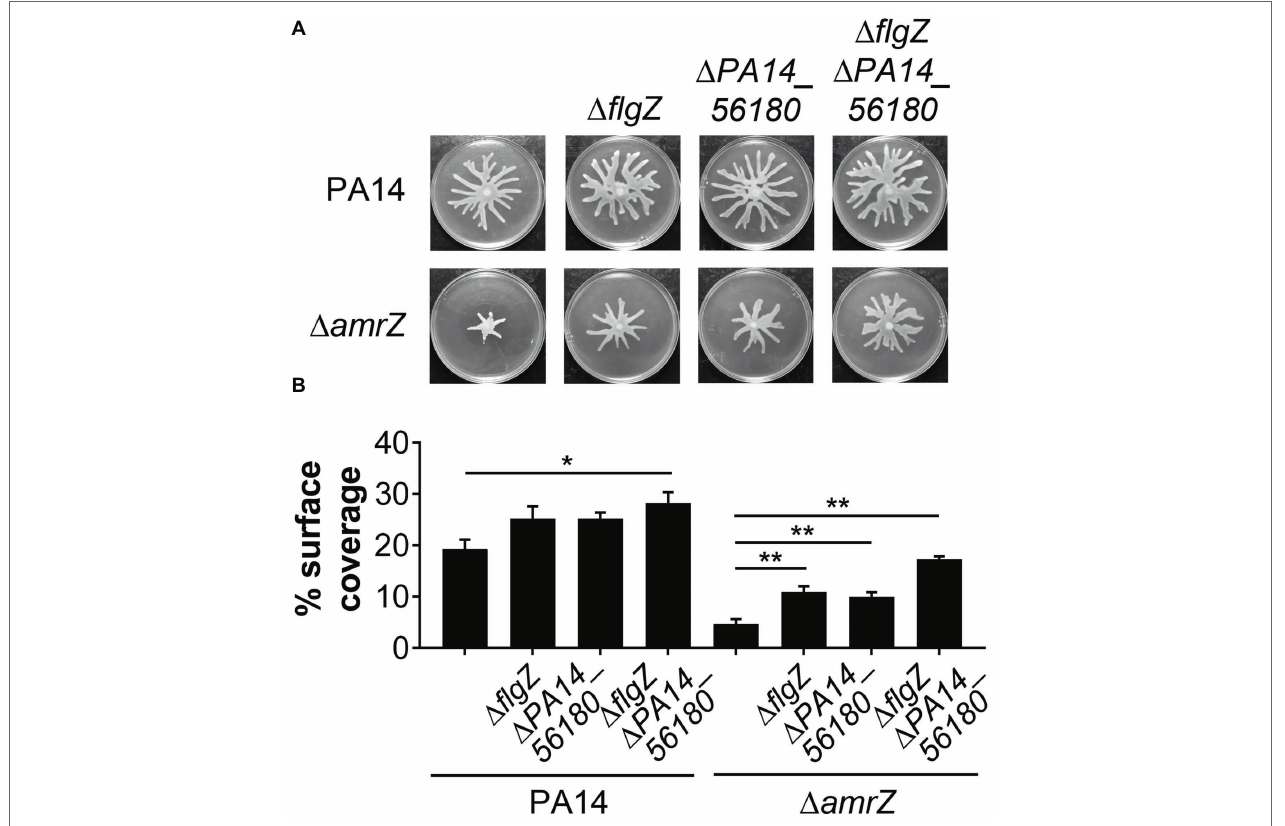
FIGURE 6 | FlgZ and PA14_56180 contribute to swarming motility repression of the amrZ mutant. (A) Representative swarm plates of the indicated strains. (B) Percentage of the plate surface occupied by the respective swarms shown in (A) . Significance was determined using one-way ANOVA followed by Tukey’s multiple comparison test (* p < 0.05; ** p <